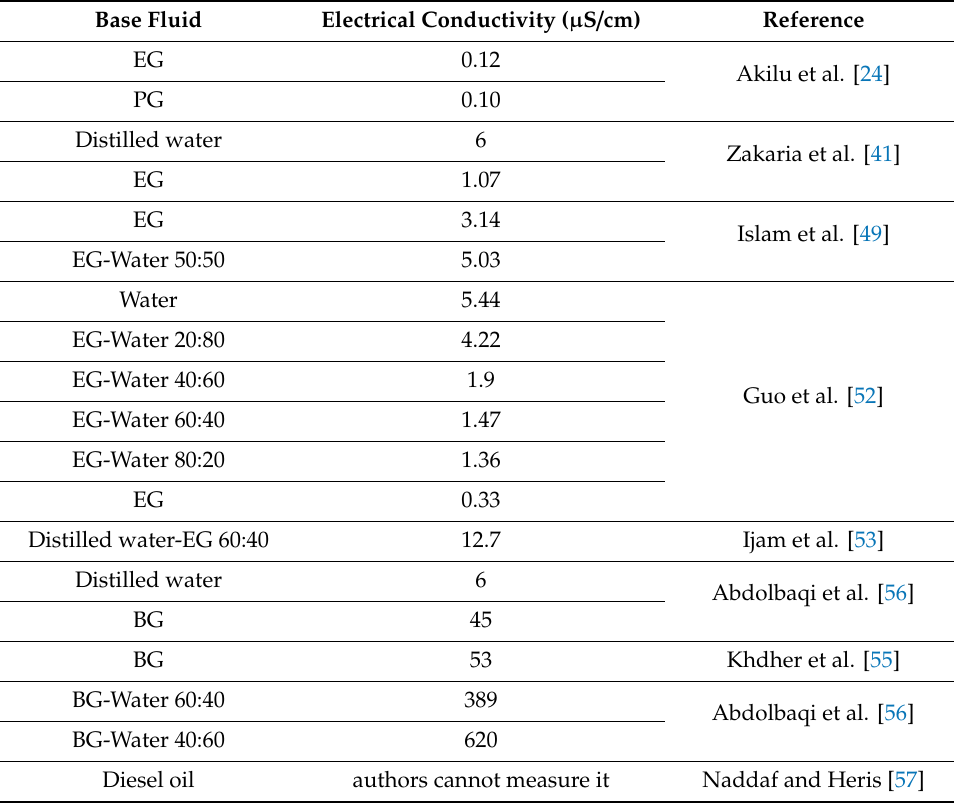
Table 2. Summary of several experimental work on electrical conductivity of base